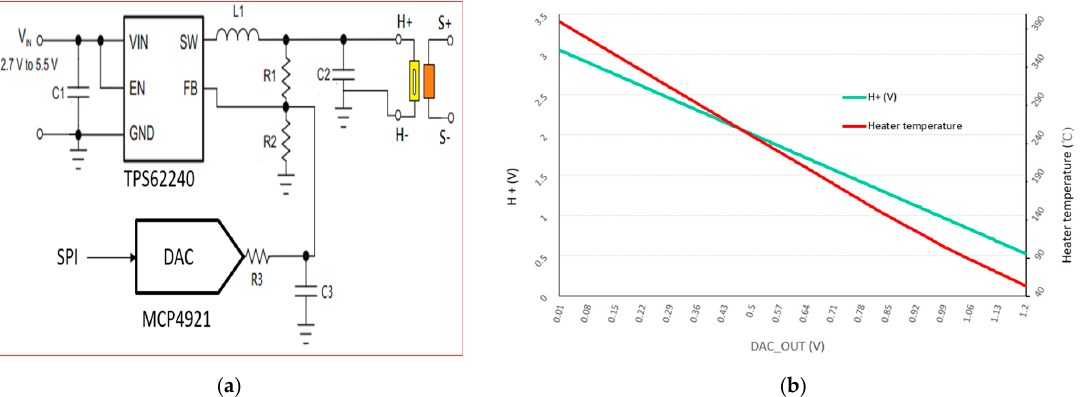
Figure 3. ( a ) Implementation of proposed architecture and ( b ) the microheater temperature and voltage as a function of DAC output voltage.